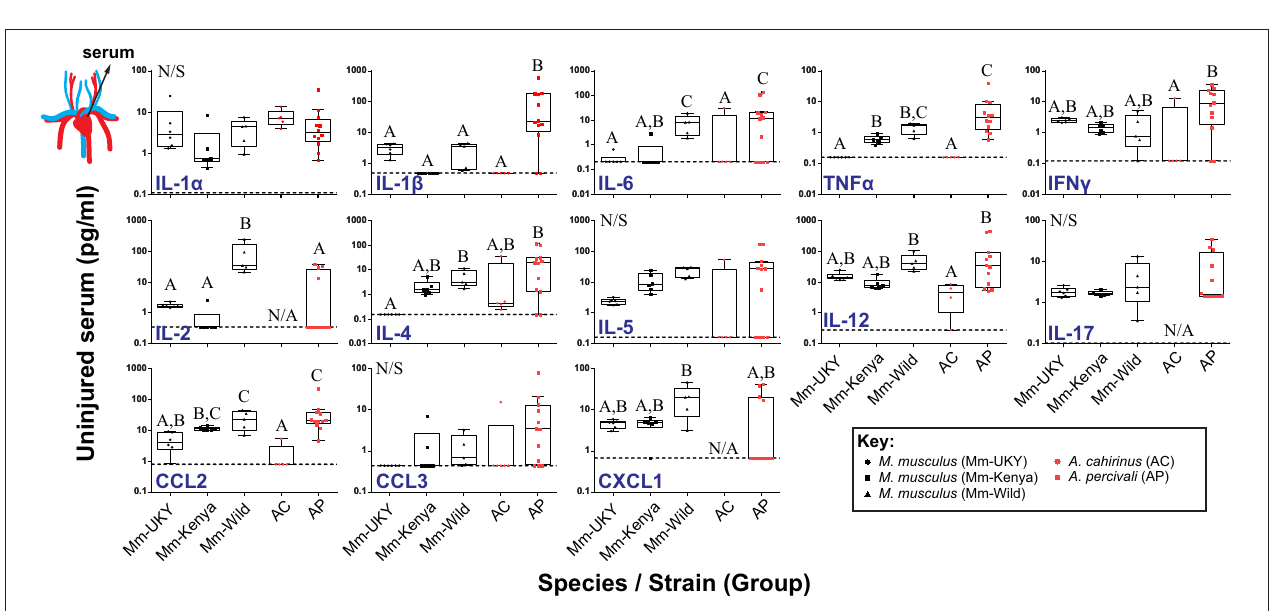
FIGURE 2 | Regenerative ability and immune status are associated with a distinct systemic immune response to injury. Comparison of cytokine concentrations in serum from uninjured animals showed higher concentrations of IL-4, IL-6, CCL2, and TNF α in wild-caught animals compared to laboratory-reared animals indicating that wild animals have a “primed” immune system. No difference was found between non-regenerators (Mm-UKY, Mm-Kenya, and Mm-Wild) (black points) and regenerators (Ac and Ap) (red points) for systemic changes the cytokines examined. Data represent box and whiskers with median, interquartile range and individual data points. N/A denotes concentrations could not be quantified in any animal of the group. The dashed line in each graph represents the lower limit of detection for the specific cytokine. N/S denotes P > 0.05 for One-way ANOVA (See Table S2 ) and different letters above the data denotes P 0.05 for Tukey-Kramer pairwise ≤ comparisons (See Data File S1 ). Data represent mean and S.E.M. for at least n 5 animals per species per timepoint. The cartoon circulatory system indicates that = the measured values were from